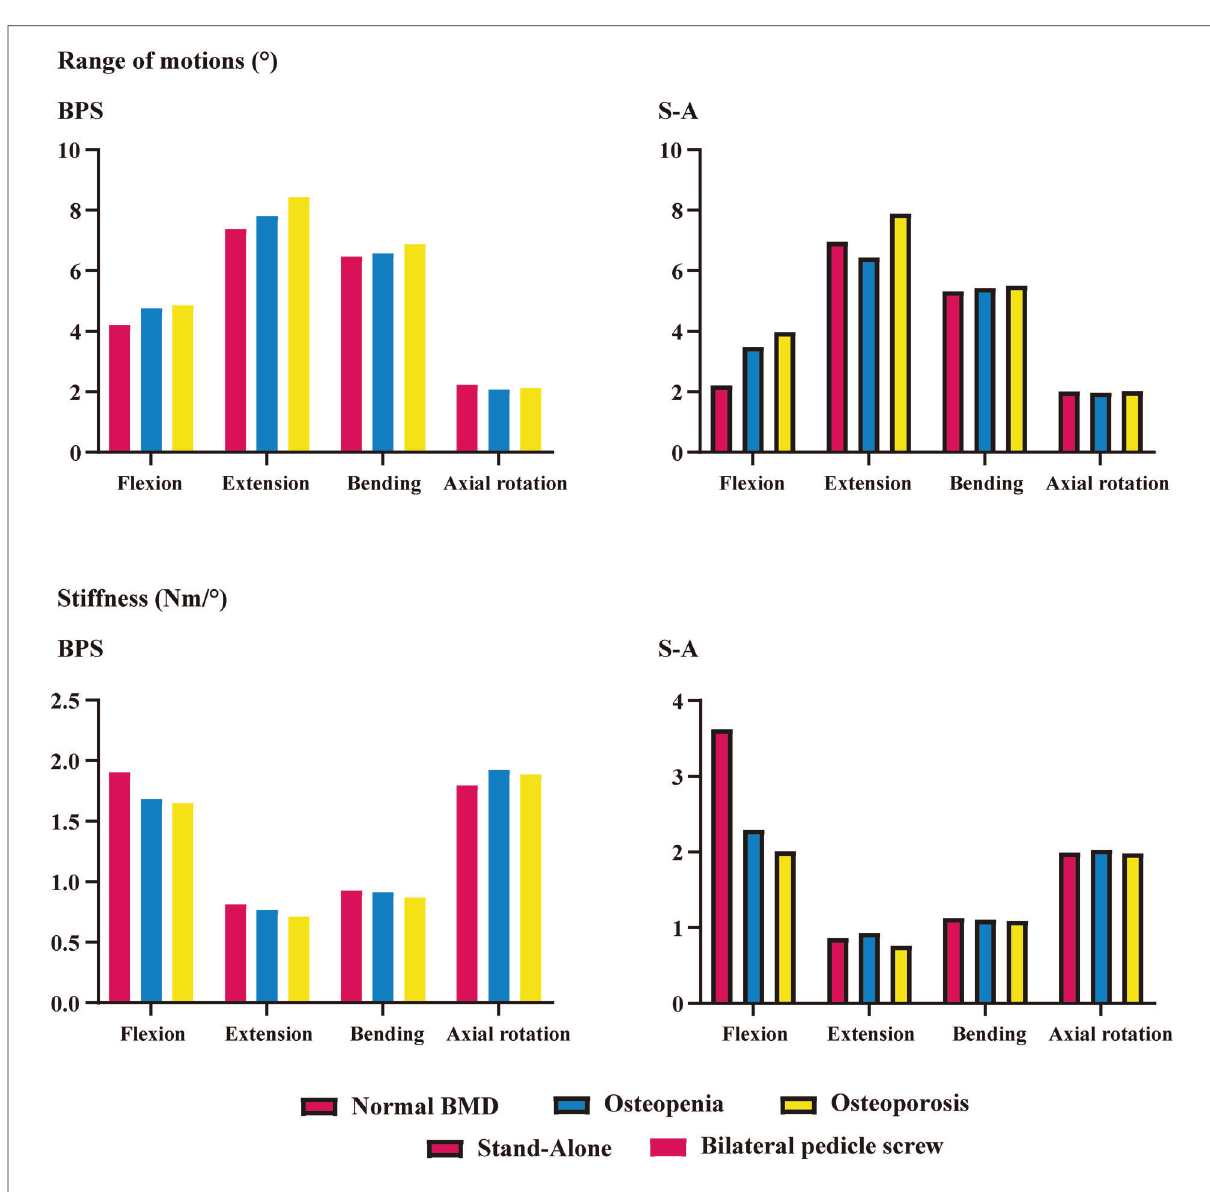
FIGURE 2 ROMs and stiffness of the motion segment cranial to the surgical segment (L3 –